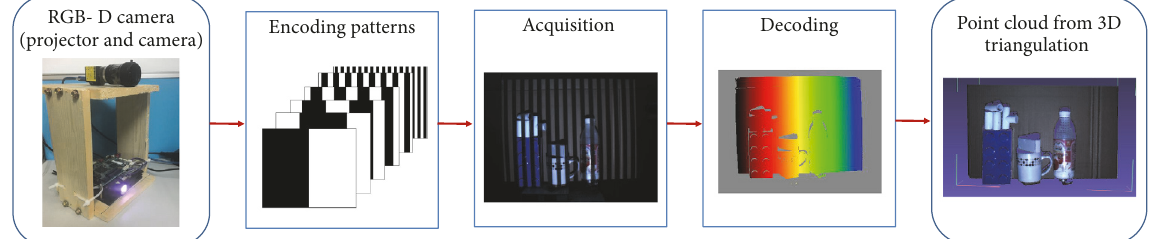
Figure 1: The overview of our RGB-D camera system with the structured light technique. The encoding pattern is a gray-code pattern. The acquisition is the images captured by the camera for each pattern in the sequence. The decoding is a coded map.